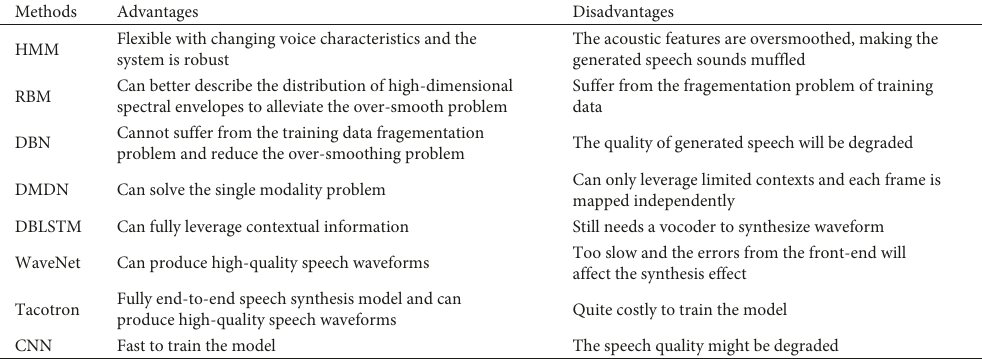
Figure 3: The advantages and disadvantages of the different methods in speech synthesis [21].